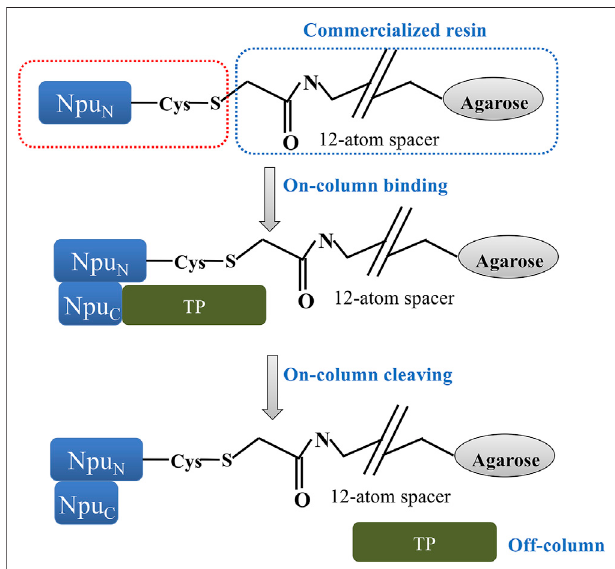
FIGURE 9 | This fi gure was adapted from a patent fi led by scientists at theOhioStateUniversity(WoodandShi,2018;PatentNo.:US10066027B2; prioritized in 2015, fi led in 2016 and approved in 2018, with continuation Patent No.: 10669351 B2) and shows a scheme of split intein immobilization and the corresponding puri fi cation method. The N-terminal intein segment (Npu N ) is expressed and puri fi ed from a recombinant protein expression host (in this case E. coli ), and then immobilized onto a commercially available immobilization resin (e.g., SulfoLink ™ resin). The charged resin can be used to directly capture the intein C-terminal intein segment (Npu C ), which has been fused to a Target Protein (TP). After the feed impurities have been washed away, the intein can be induced to release the target protein (TP) from the column matrix by a pH or temperature shift. The cleaved tag-free target can be directly collected from the column, and the column can be regenerated to remove the cleaved intein C-terminal segment, allowing multiple rounds of puri fi cation on a single batch of resin.